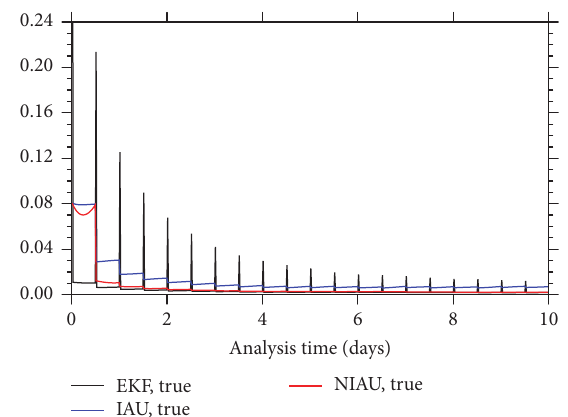
Figure 2: Variable-averaged RMS time tendency difference between assimilated variables and true states using the EKF (black line), the IAU (blue line), and the NIAU methods (red line). Note that a 12- hour assimilation interval is applied.